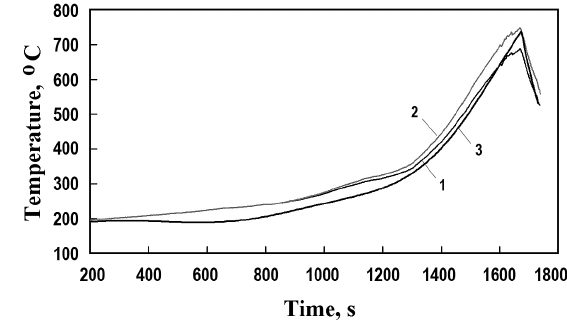
Figure 4. Time-temperature curve for experiment 1: TET read- ings (1); cladding temperature values determined using the TET readings with corrections taken into account (2); calculated cladding temperature values (3)